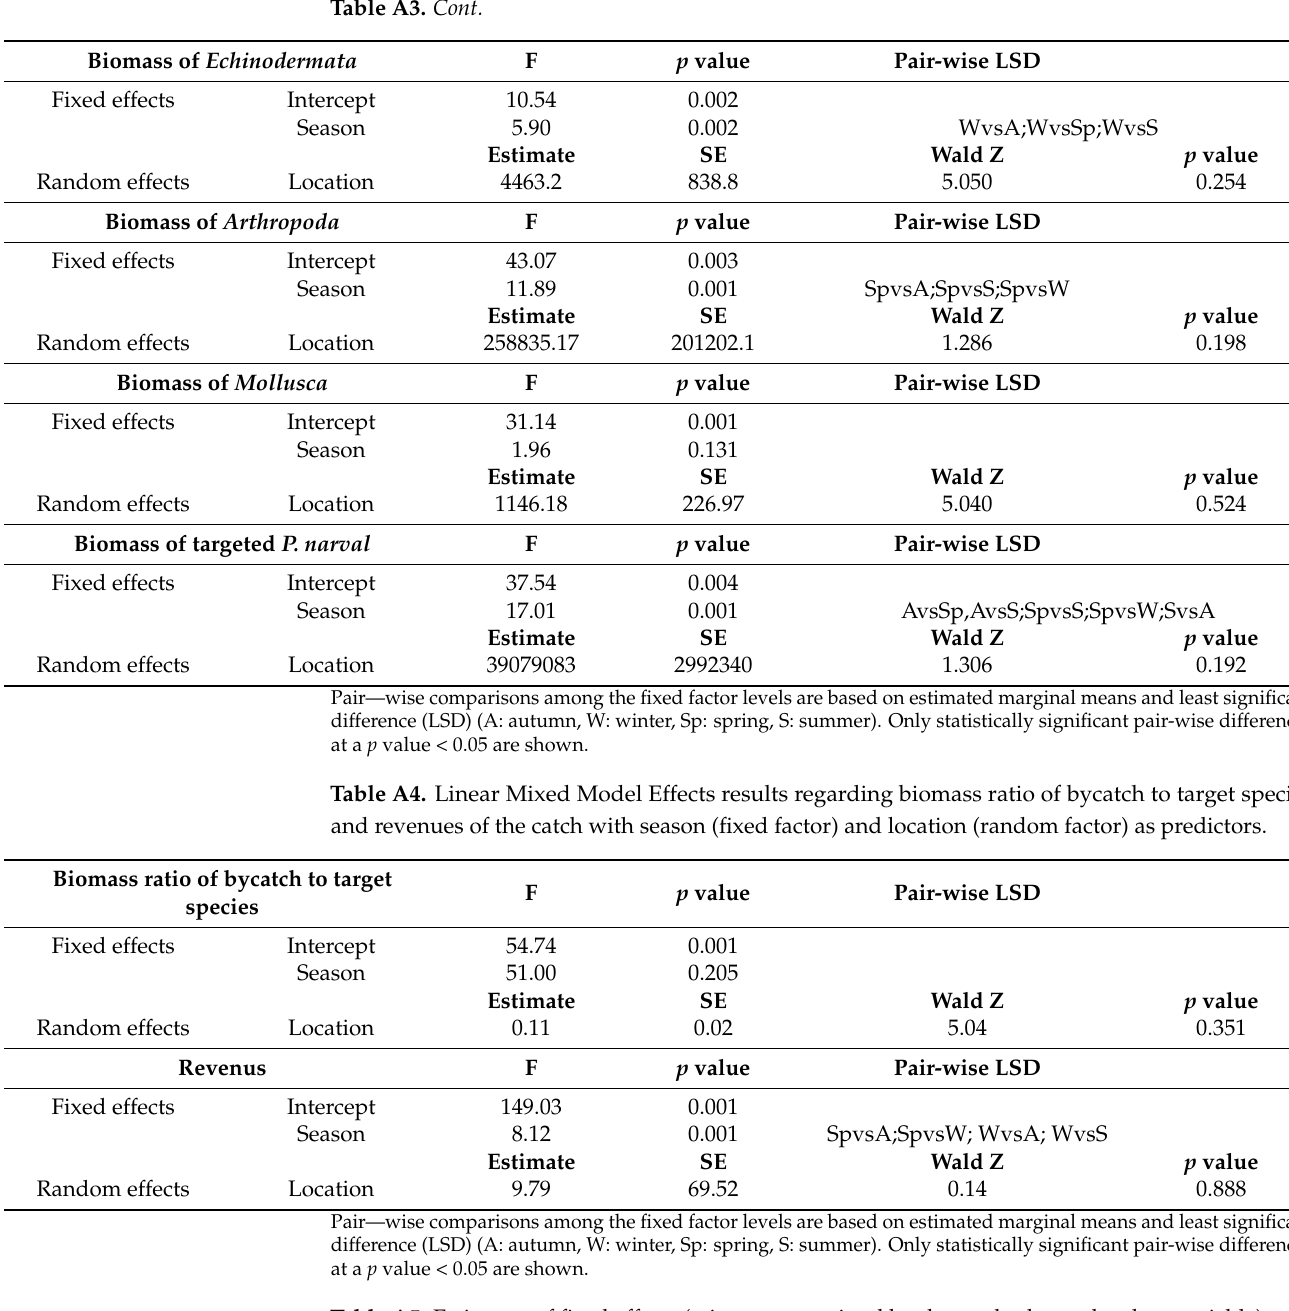
Table A5. Estimates of fixed effects (winter was omitted by the method as redundant